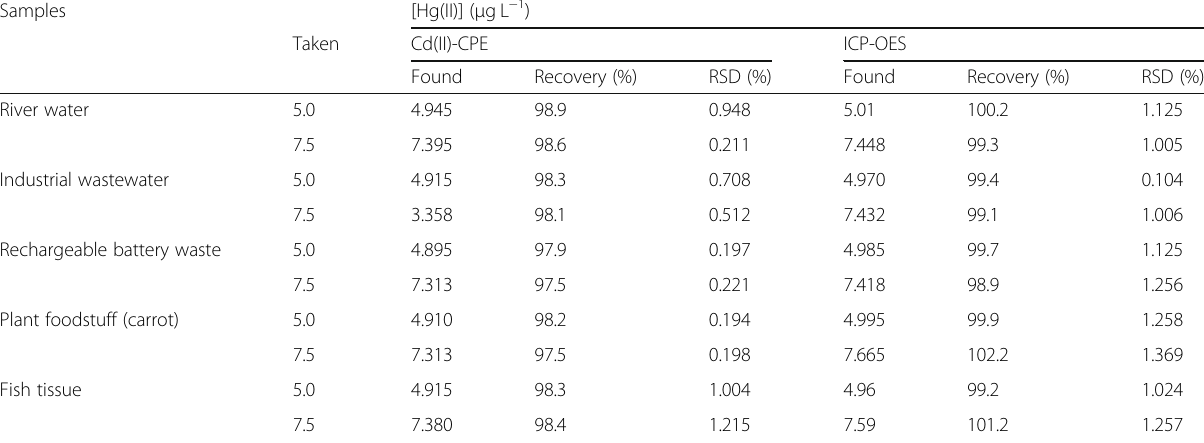
Table 3 Potentiometric determination of Cd(II) ion using the proposed modified electrode Samples